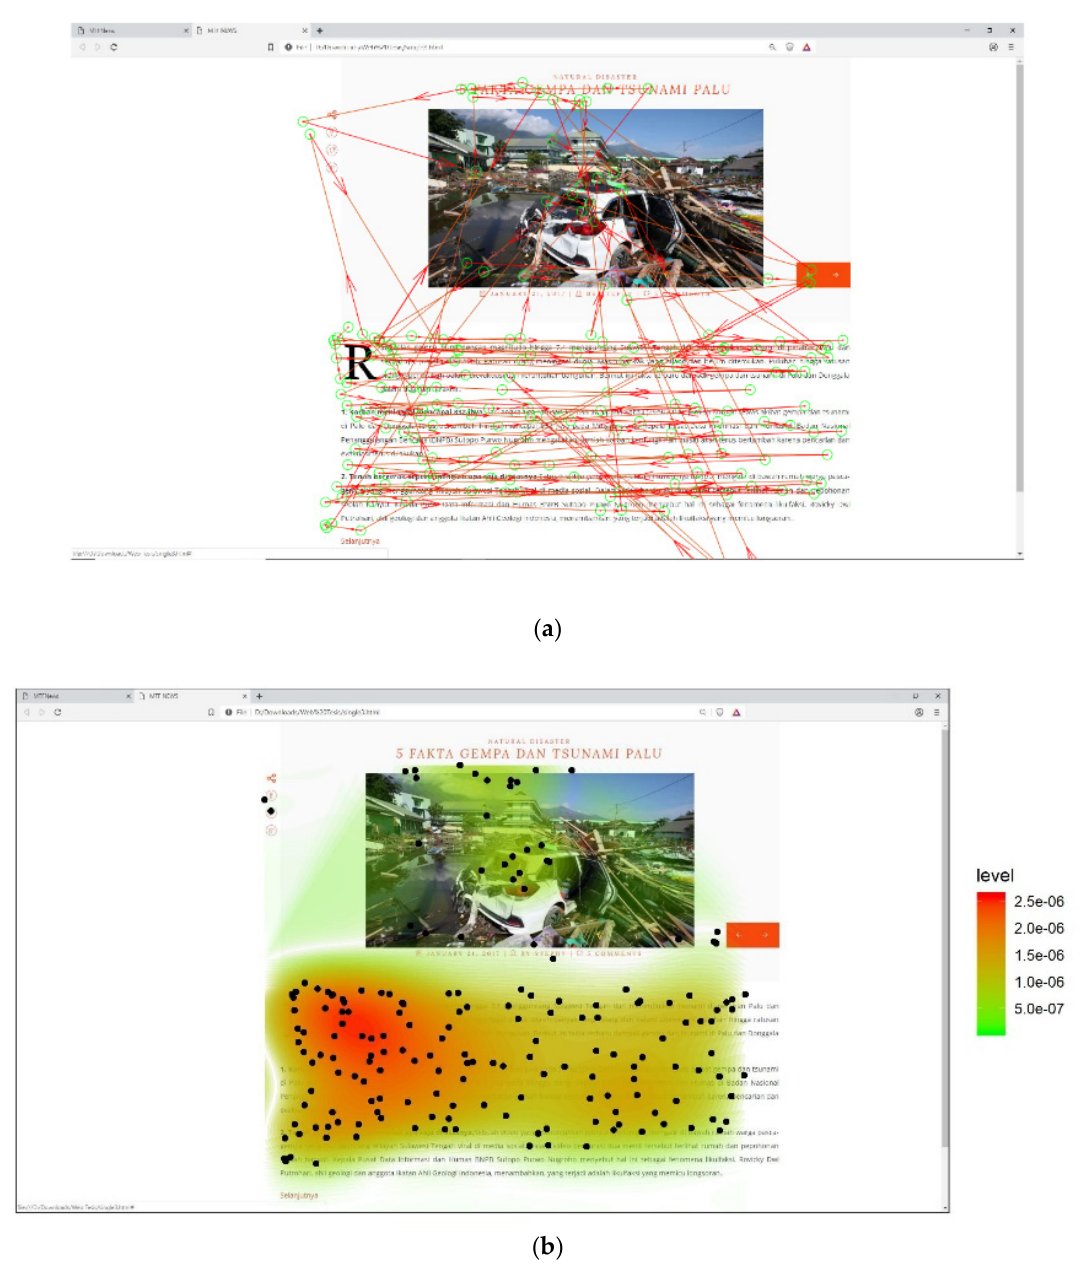
Figure 5. (a). Example of gaze plot of medium anxiety; (b) example of heat map of medium anxiety. Figure 5. ( a ) Example of gaze plot of medium anxiety; ( b ) example of heat map of medium